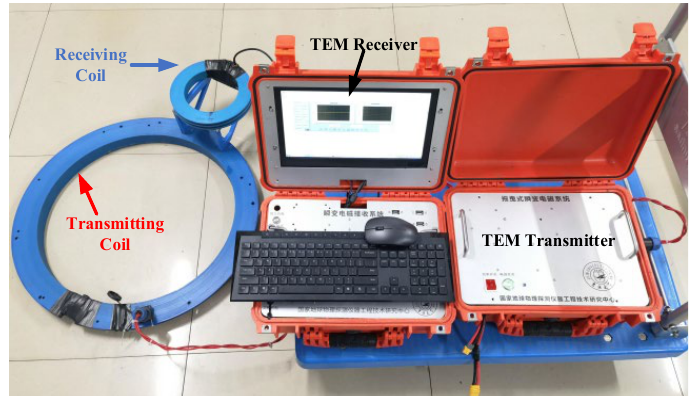
Figure 14. The laboratory simulation comparison test and TEM devices.